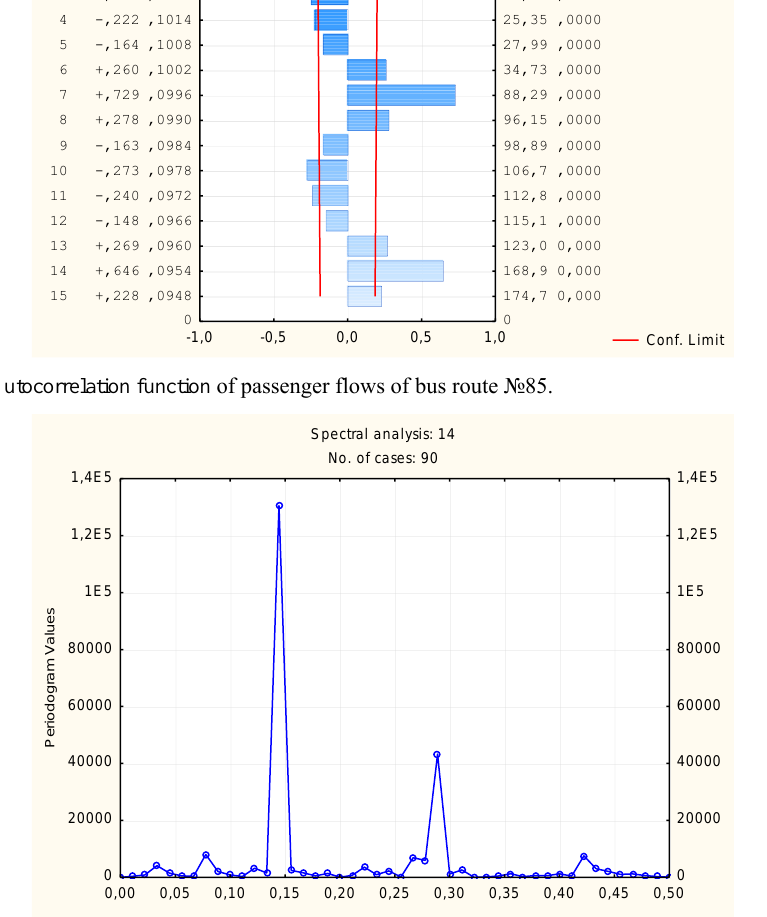
Thus, all passenger flows have a clearly expressed seasonal component at a frequency of 0.144 that corresponds to the ideal cycle. In addition, there is another seasonal component at a frequency of 0.28 that corresponds to the half-weekly component. The contribution of this component is smaller, but taking it into account can improve the accuracy of the simulation